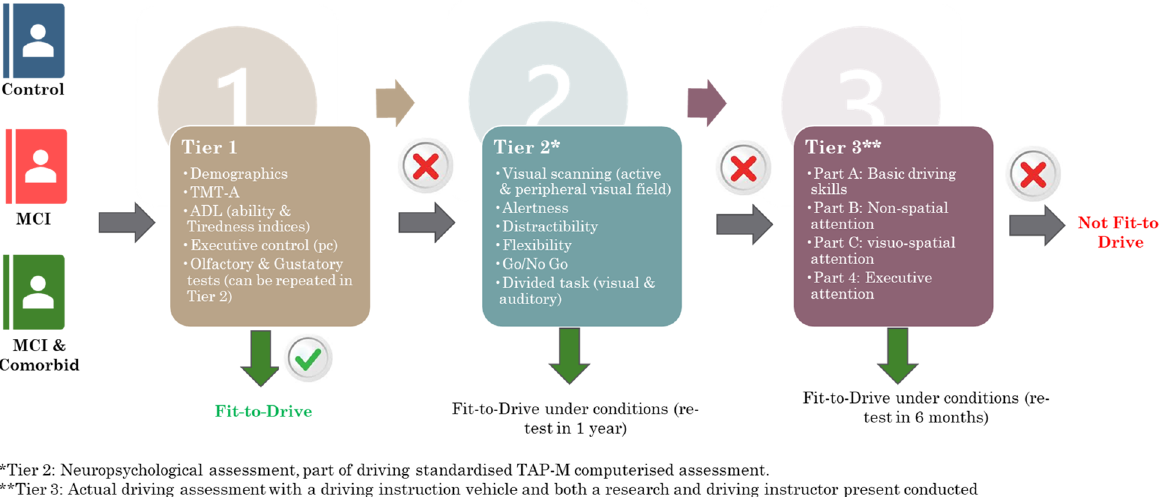
Figure 6. AGILE-adapted assessment